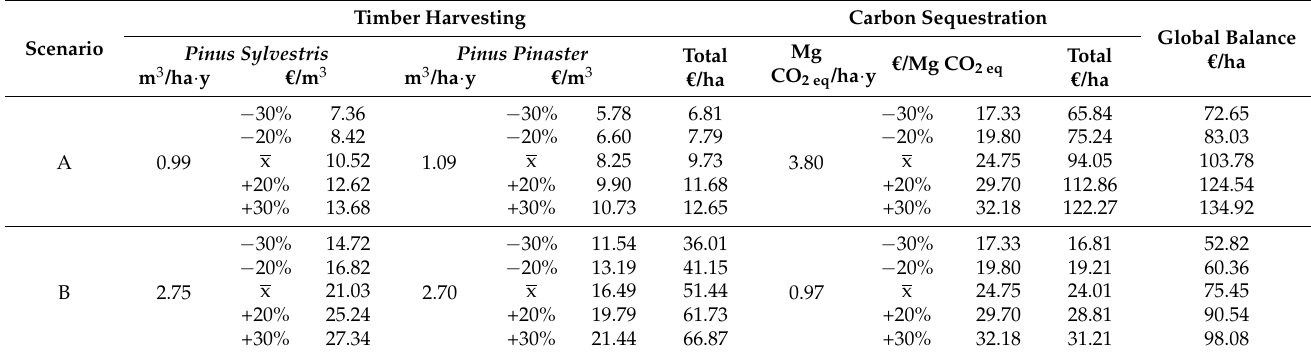
Table 2. Financial valuation of studied scenarios. x means average